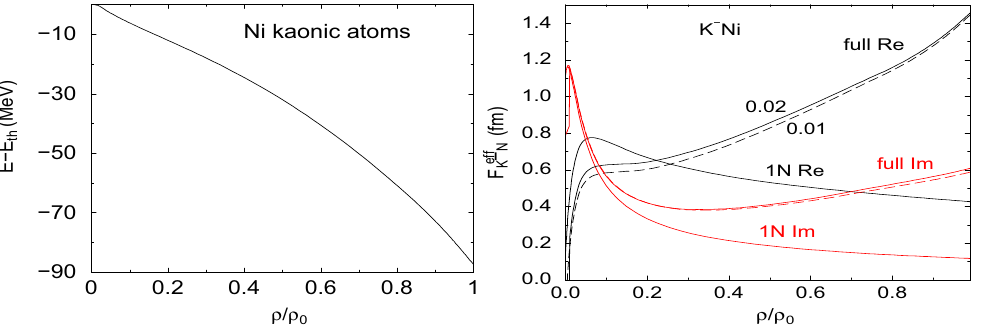
Figure 3. Left: subthreshold energies probed in K − -Ni atom as a function of nuclear density, calculated self- consistently within the IHW-based global fit to kaonic atoms using Eq. (7). Right: Kaonic-atom globally fitted amplitude F e ff K − ( ρ ), marked “full", and the in-medium IHW-based amplitude F K − N ( ρ ) in the absence of many- nucleon contributions, marked “1N", as a function of nuclear density in Ni [16]. Solid (dashed) curves are for matching to free-space amplitudes at 0.02(0.01) ρ 0